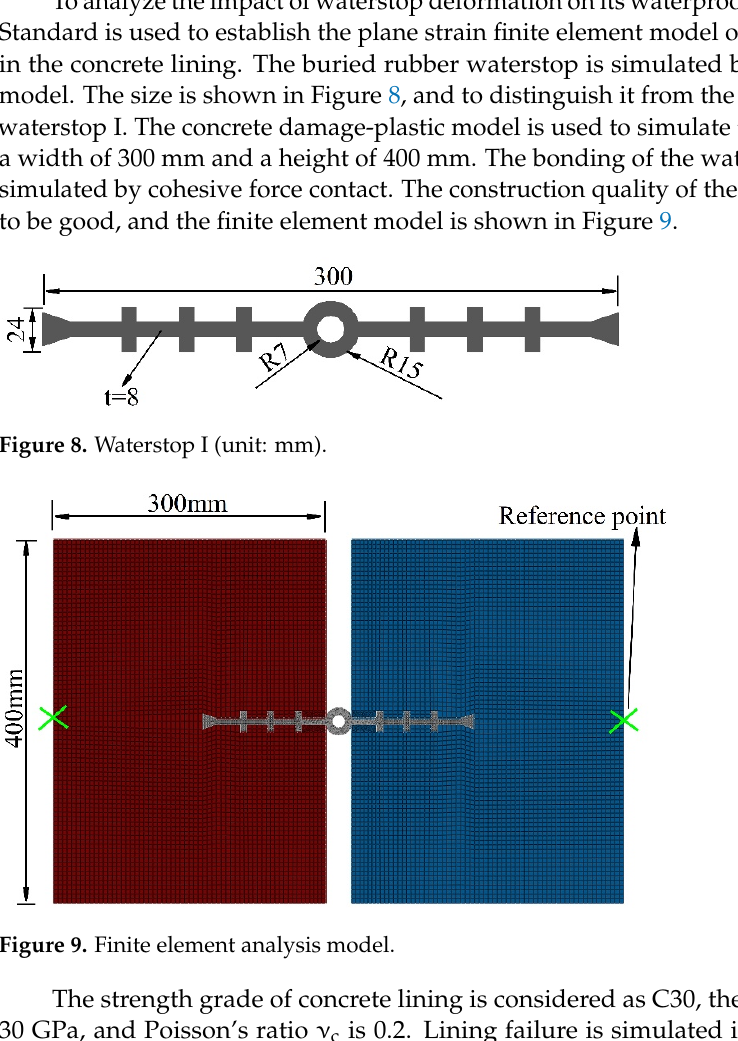
Figure 7. The initial contact pressure of the waterstop.